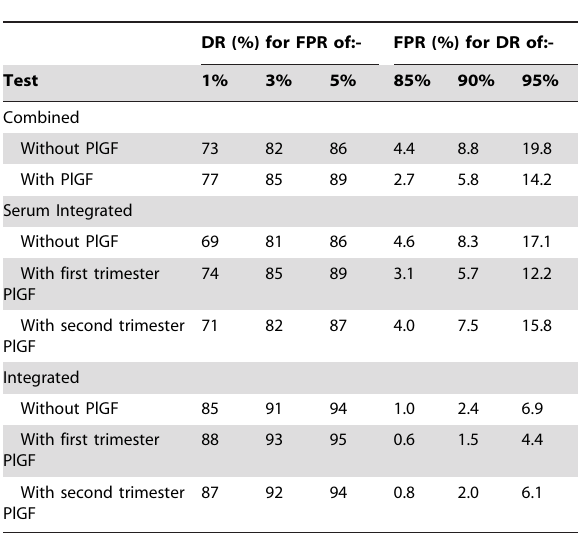
Table 5. Screening performance according to detection and false-positive rates of the Combined, Quadruple and Integrated tests with and without the addition of first trimester (11–13 weeks 1 ) or second trimester placental growth factor